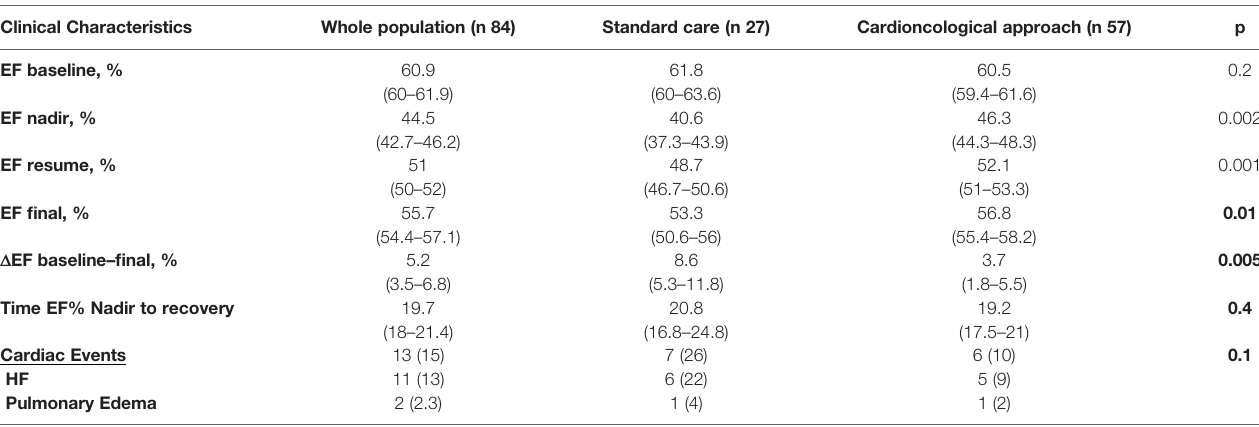
TABLE 2 | Echocardiographic parameters and Cardiac events (n